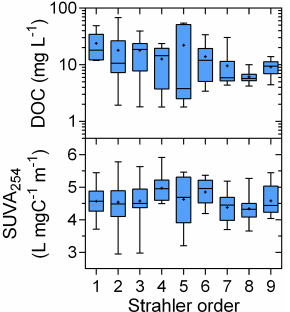
Figure 9. DOC concentrations and DOM aromaticity (SUVA 254 ) across a gradient of streams and rivers in the Congo Basin as a func- tion of stream order. The box spans the interquartile range (25th– 75th percentiles), whiskers correspond to min–max values, and the horizontal bar and cross correspond to the median and average, re-